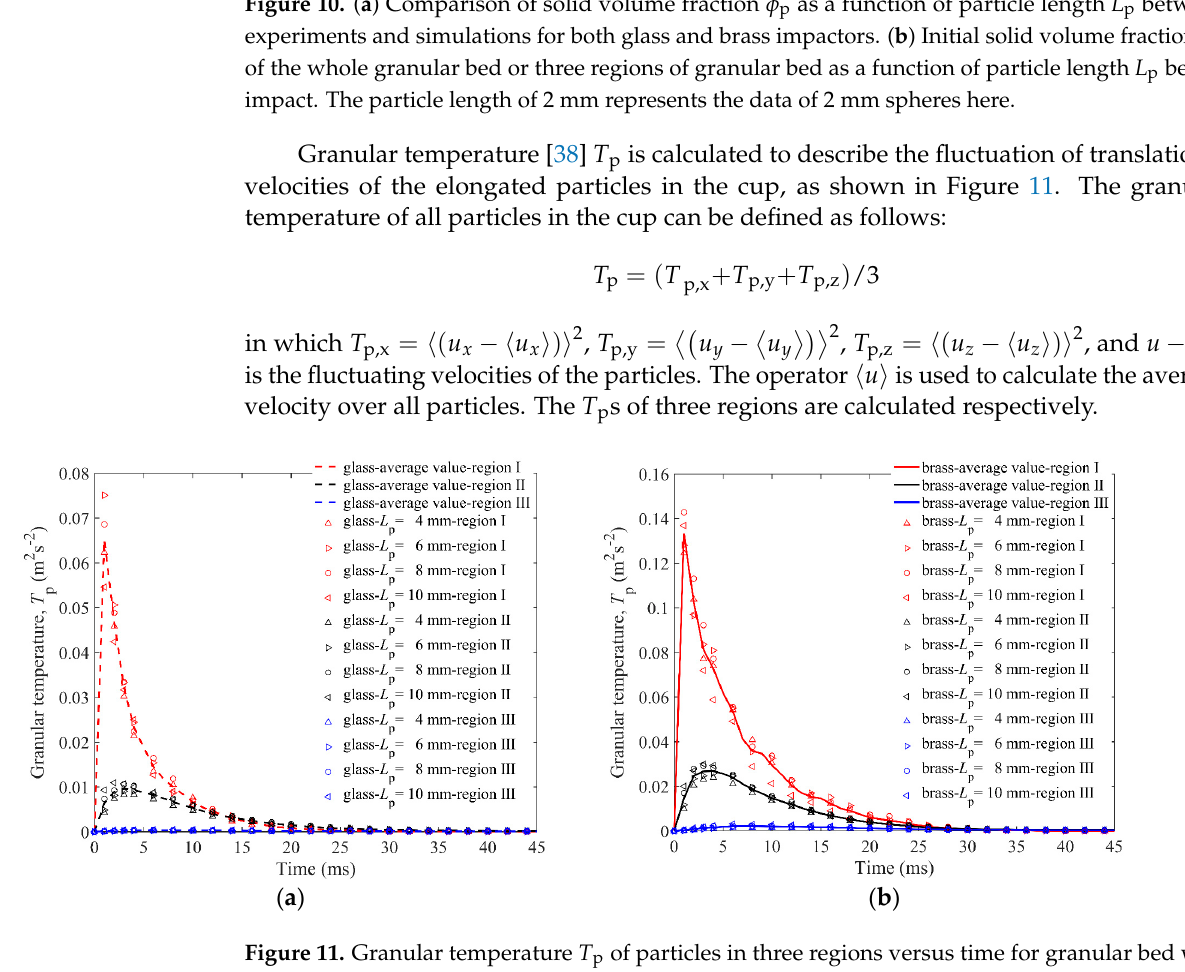
Figure 10. ( a ) Comparison of solid volume fraction ϕ p as a function of particle length L p between experiments and simulations for both glass and brass impactors. ( b ) Initial solid volume fraction ϕ p of the whole granular bed or three regions of granular bed as a function of particle length L p before impact. The particle length of 2 mm represents the data of 2 mm spheres here.